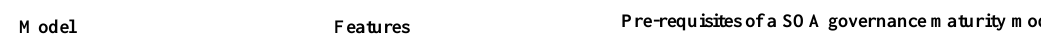
Table 1. Review of SOA governance maturity